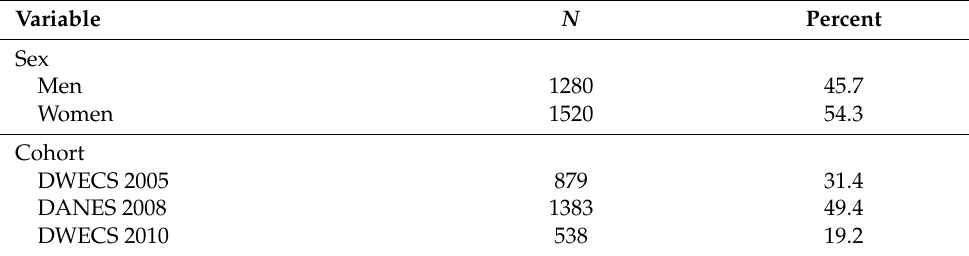
Table 1. Baseline characteristics of the study sample ( N =